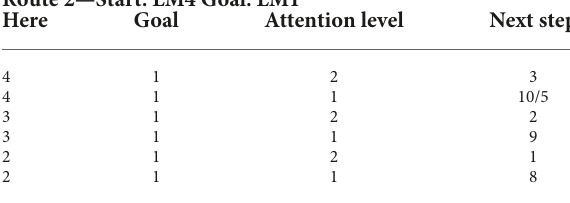
TABLE 1 Rule set of the lookup table based fuzzy system for Route 1 with the starting point at LM1 and ending at LM6 (as Goal) from the assumed cognitive map in Figure 3.